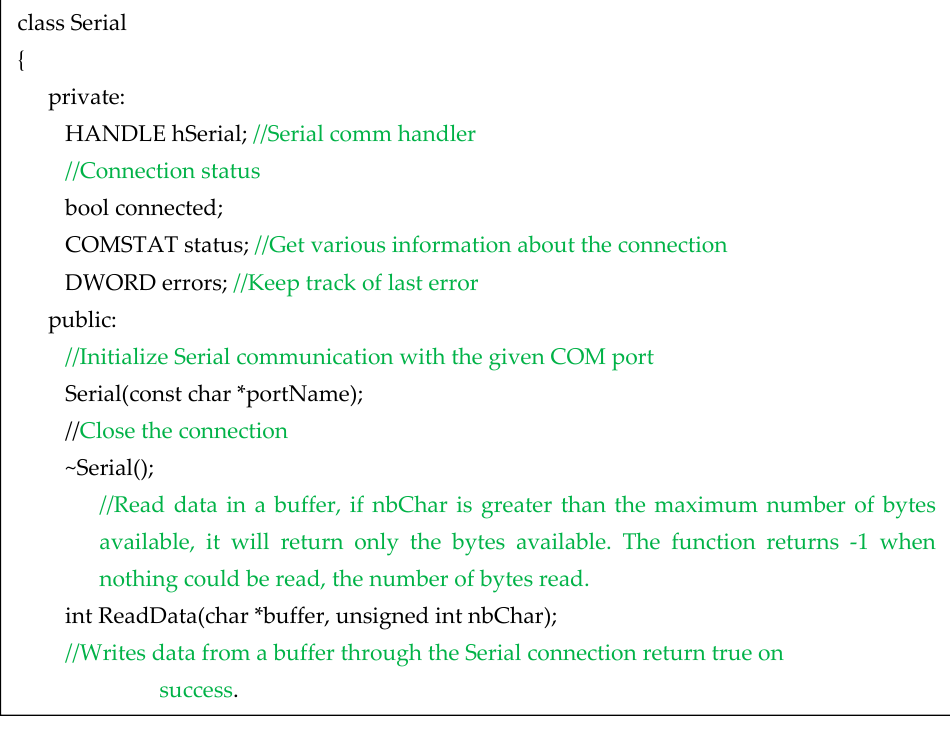
Figure 11. The code for transferring the Encryption Key to the